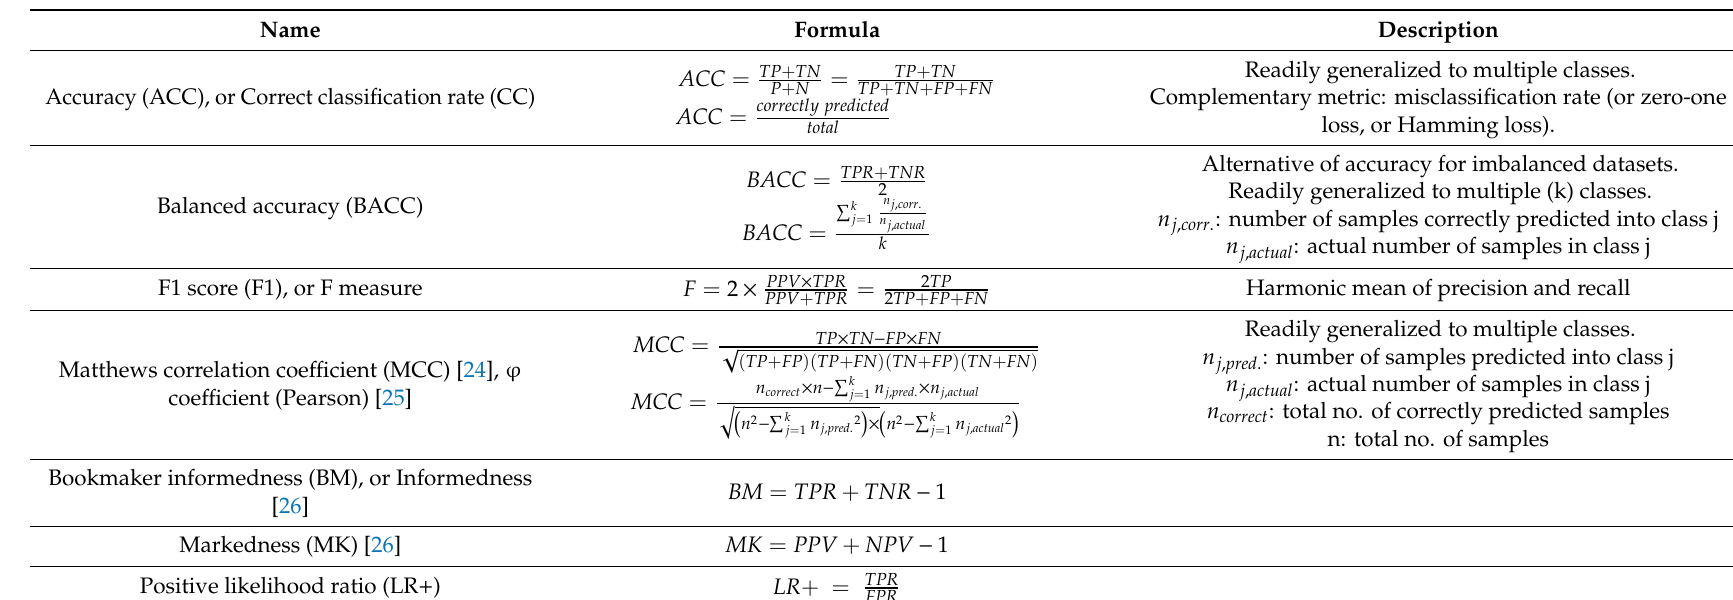
Table 5. Local performance metrics for 2-class classification—Two-sided. ( n : total number of samples, k : total number of